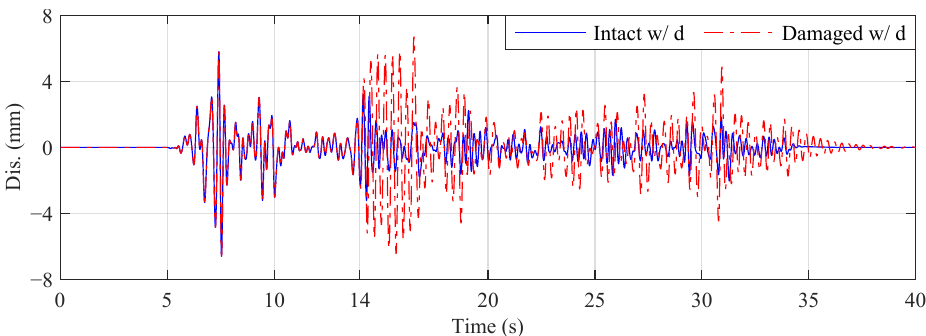
Figure 9. Third-floor displacement responses of Intact w/ d and Damaged w/ d (El Centro earth- quake, Case 4).